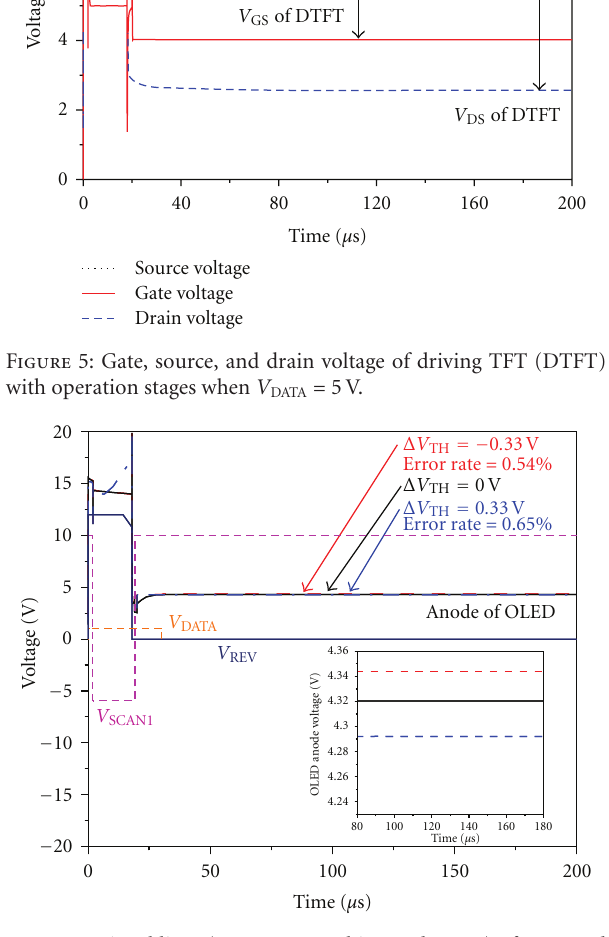
Figure 6: Signal lines (Scan1, reverse bias, and V DATA ) of proposed pixel circuit at V DATA = 1V and the anode voltage of OLED with varied threshold voltage of DTFT ( Δ V TH = − 0.33 V, 0V, and +0.33V), the insert figure clearly shows of OLED anode voltage under threshold voltage variation of DTFT, and the error rate of OLED is below 0.7%.